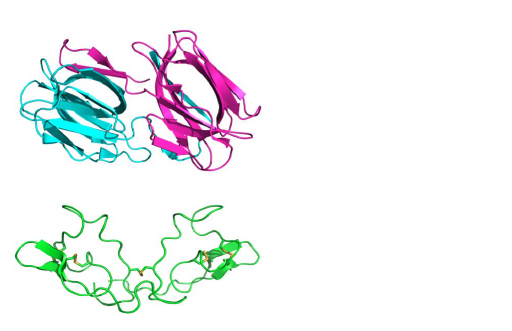
Figure 1. Ribbon diagrams of the three dimensional structures of the lectins griffithsin and scytovirin. (A) griffithsin (GRFT), a 25 kDa-protein (a domain-swapped homodimmer of 12.7-kDa subunit) was originally isolated from the red algae Griffithsia sp.; (B) Scytovirin, a 9.7-kDa protein, was originally isolated from the blue-green algae Scytonema varium